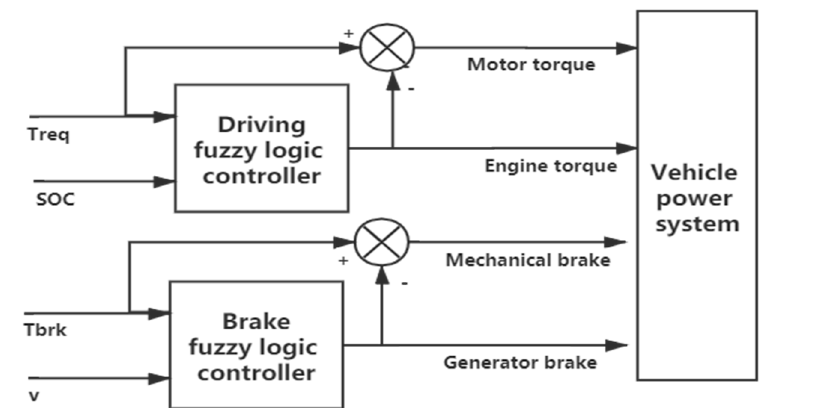
Figure 11. Fuzzy logic control basic structure.